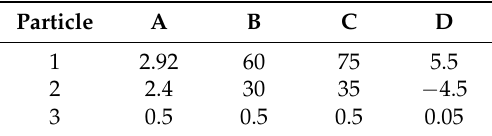
Table 7. Changed position of particles after the first iteration.